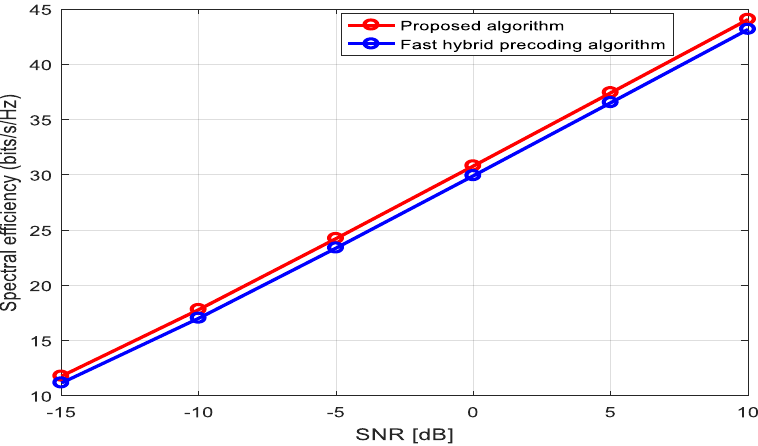
Figure 3. Spectral efficiency of proposed of algorithm .